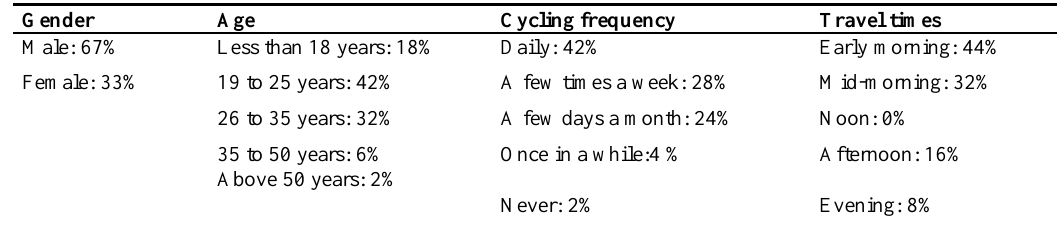
Table 2. Cycling demographics and patterns.